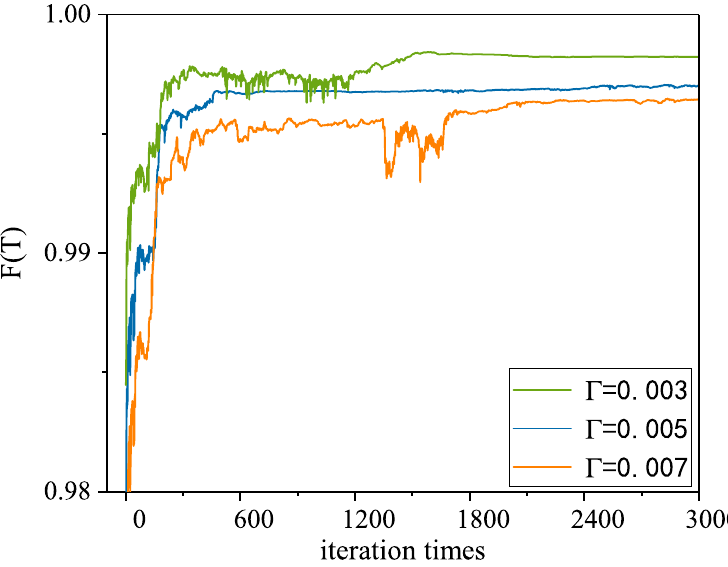
Figure 2. The variation of the fidelity F ( T ) vs the number of iteration times for different Γ . γ = 2 and Tem =